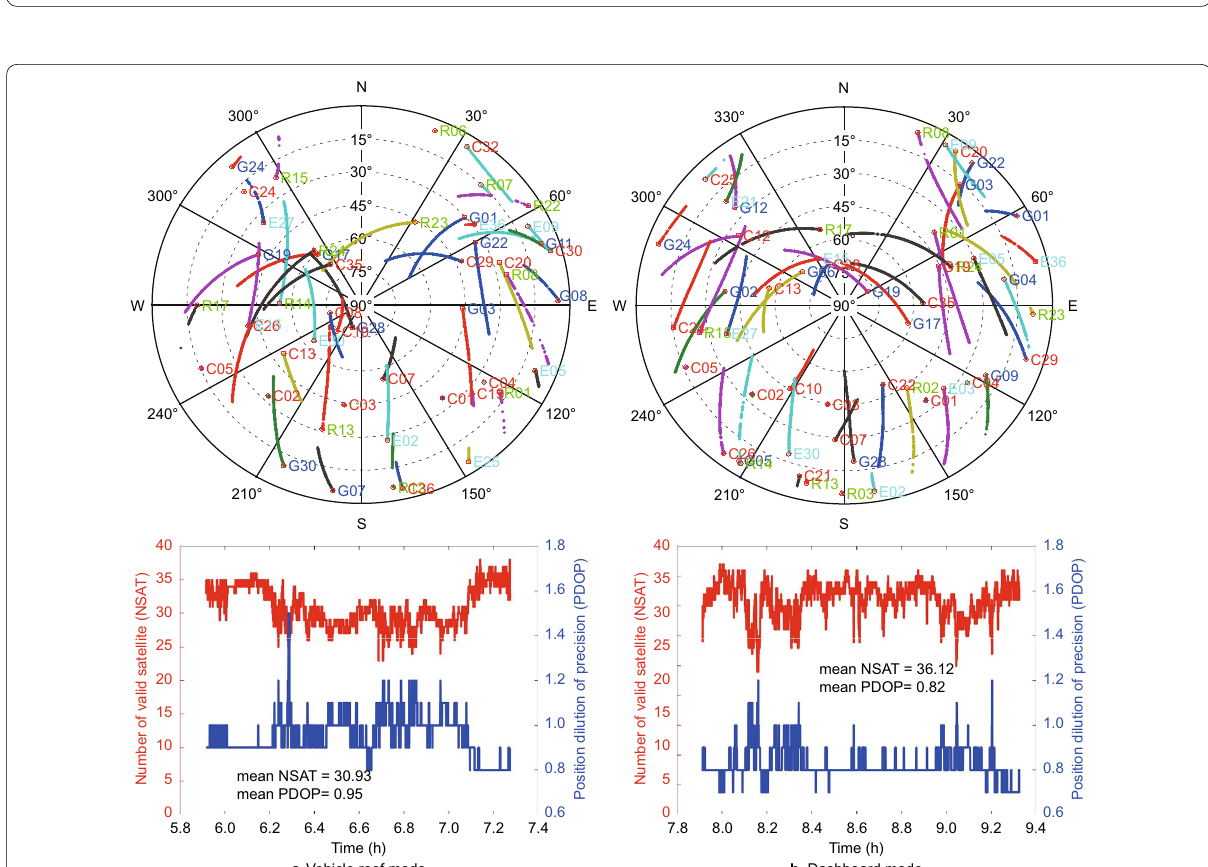
Fig. 2 The distribution and the number of the observed satellites in the a vehicle-roof mode and b dashboard mode kinematic